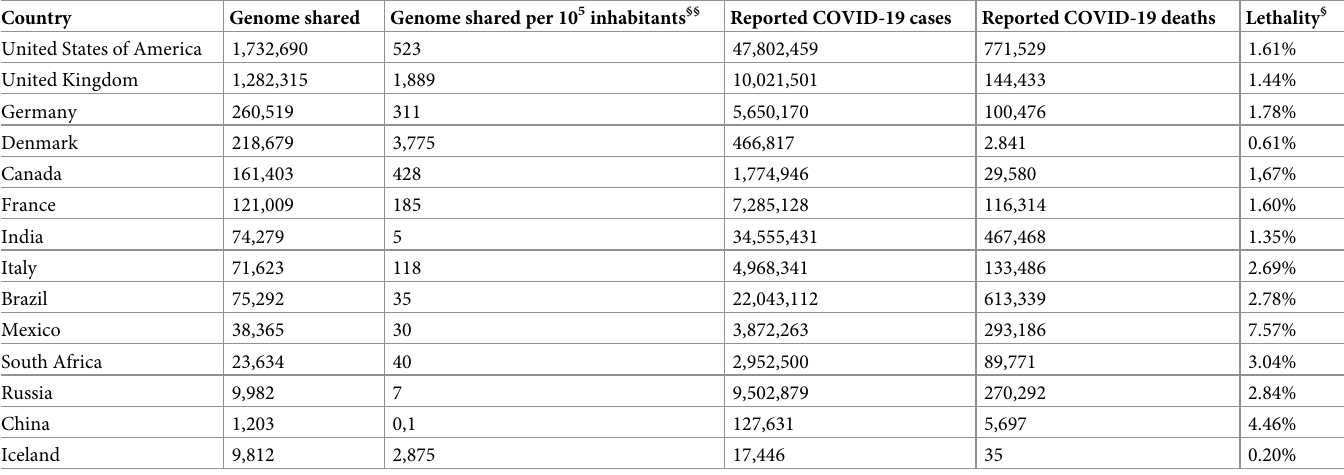
Table 1. Genome shared and lethality per country.